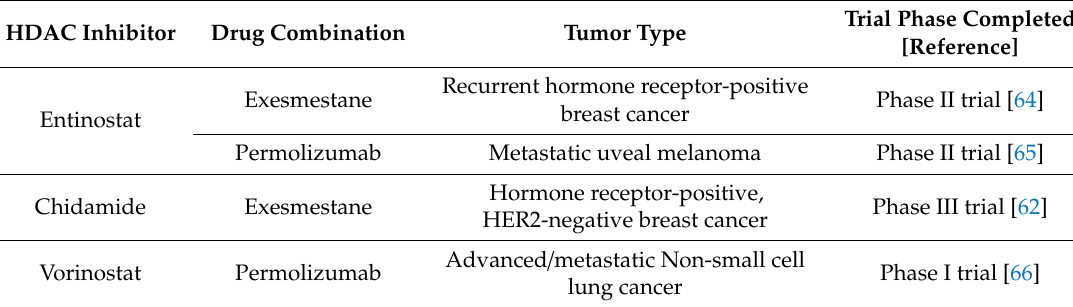
Figure 4. Chemical structures of four HDAC inhibitors (vorinostat, belinostat, romidepsin, pracinostat, entinostat, chidamide and panobinostat). Vorinostat, belinostat, romidepsin and panobinostat are FDA-approved. Table 2. HDAC inhibitors undergoing clinical